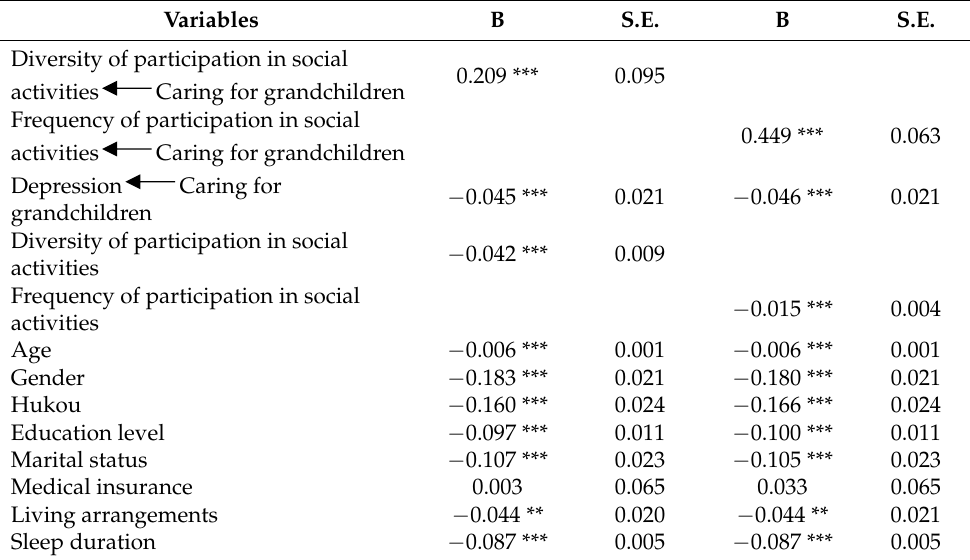
Table 5. Unstandardized and standardized path coefficients for the structural model.